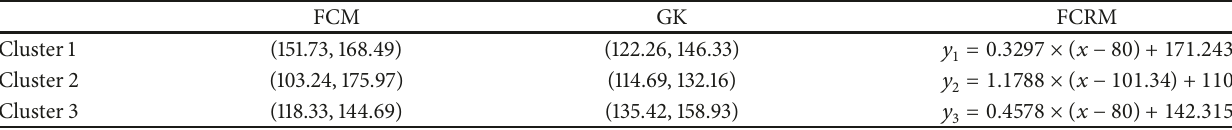
Table 4: Centroids of FCM, GK, and FCRM with 𝑐 = 3 in ∗ a ∗ b color space.